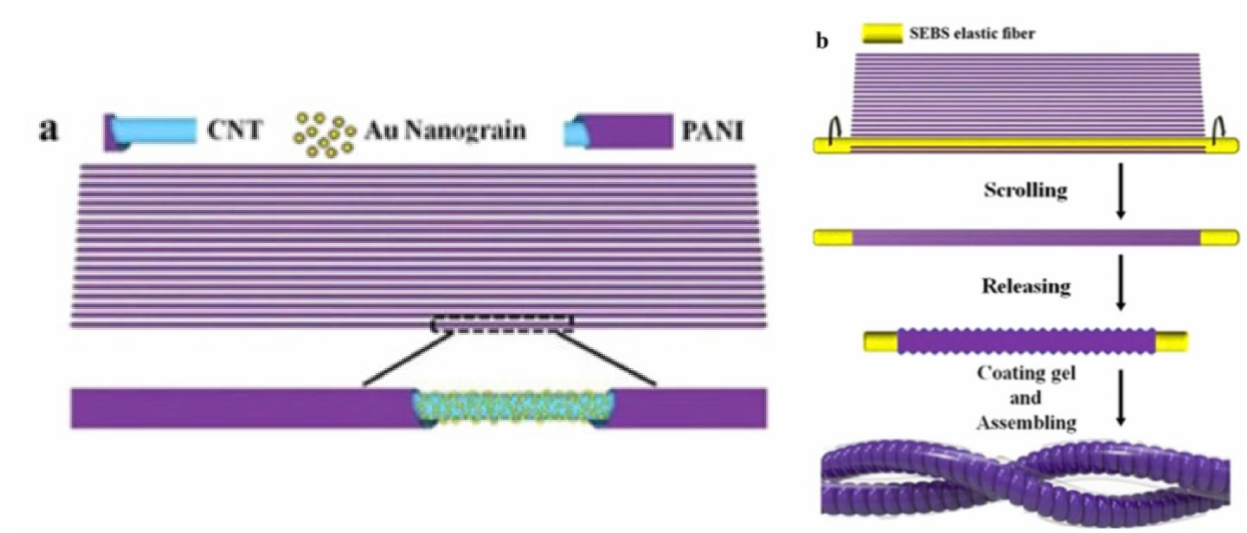
Figure 13. Schematic of the fabrication process of a stretchable linear elastomer-based FSC. ( a ) fabrica- tion of the PANI@Au x @CNT electrode, where ‘ x ’ represents the deposition time of Au nanoparticles. PANI was electrodeposited onto Au x @CNT sheets. ( b ) Stretching of elastic fiber, wrapping of the electrodes, and twisting to fabricate the SC. Reprinted with permission from